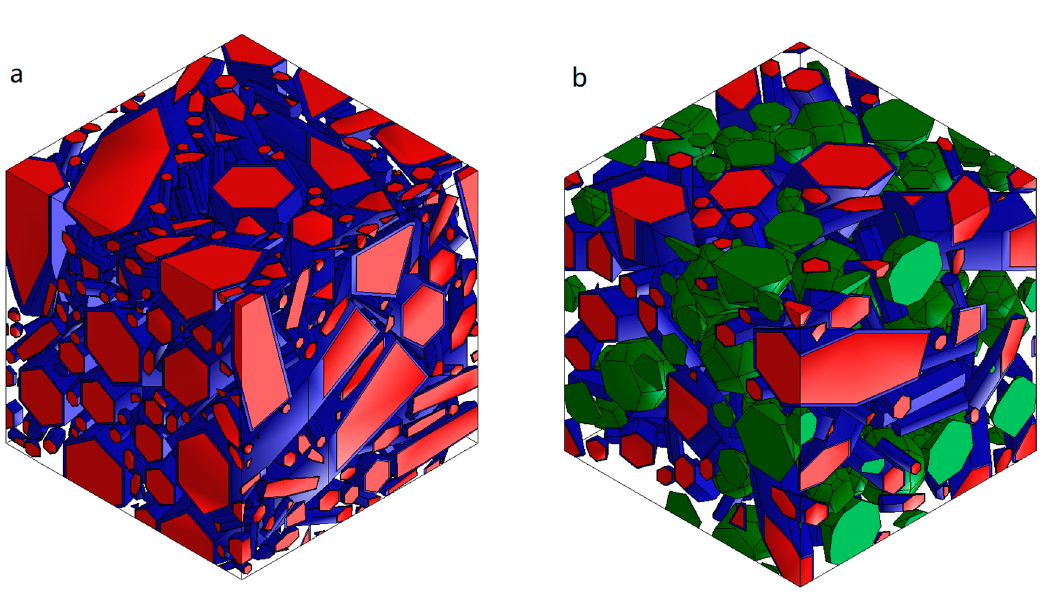
Average residual stresses in silicon nitride-based materials: finite element method (FEM)